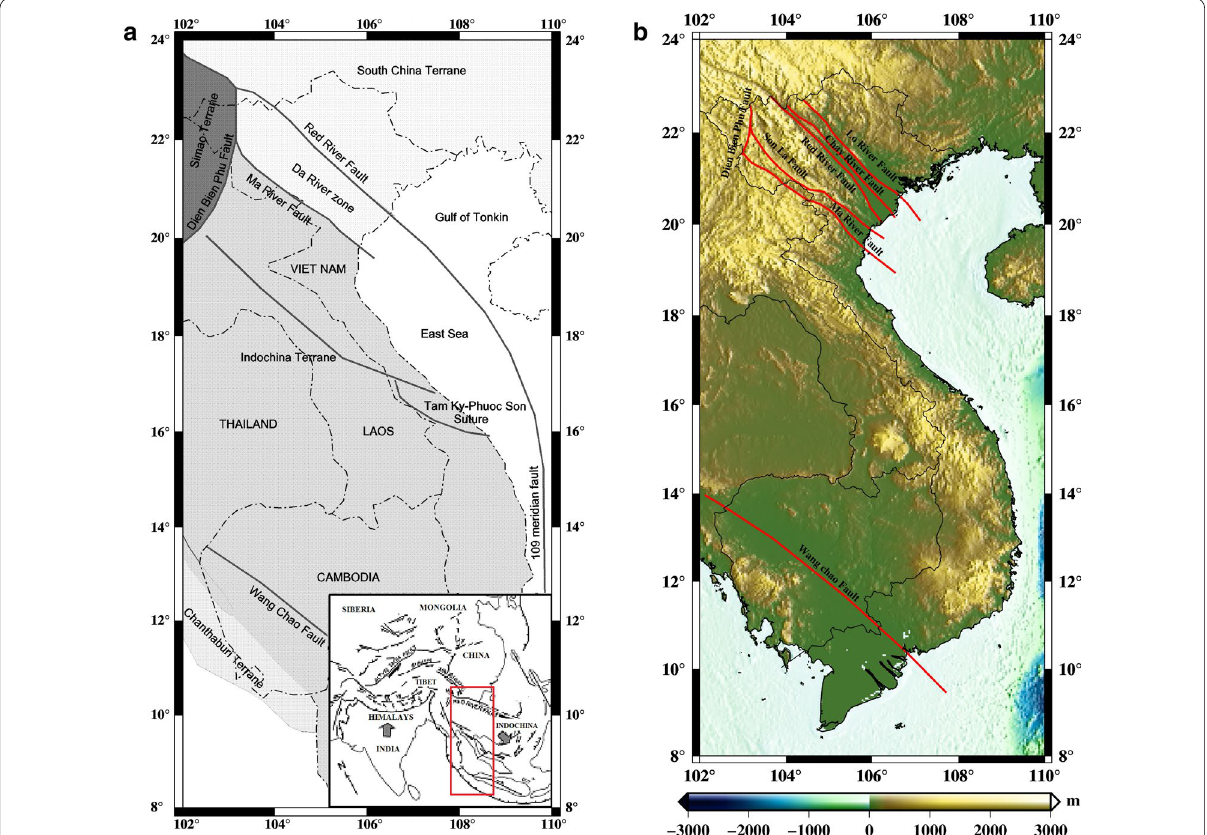
Fig. 1 a Tectonic situation in the study region and panel in the bottom right corner is a sketch regional tectonic map, modified from Gilley et al. (2003), and b topography and major active faults of the Vietnam